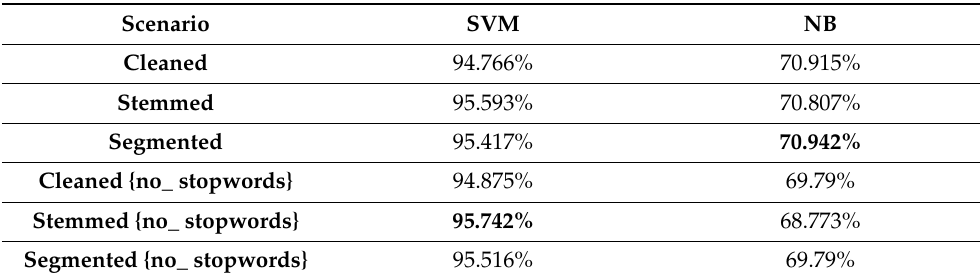
Table 5. Classifiers’ accuracy for extracted